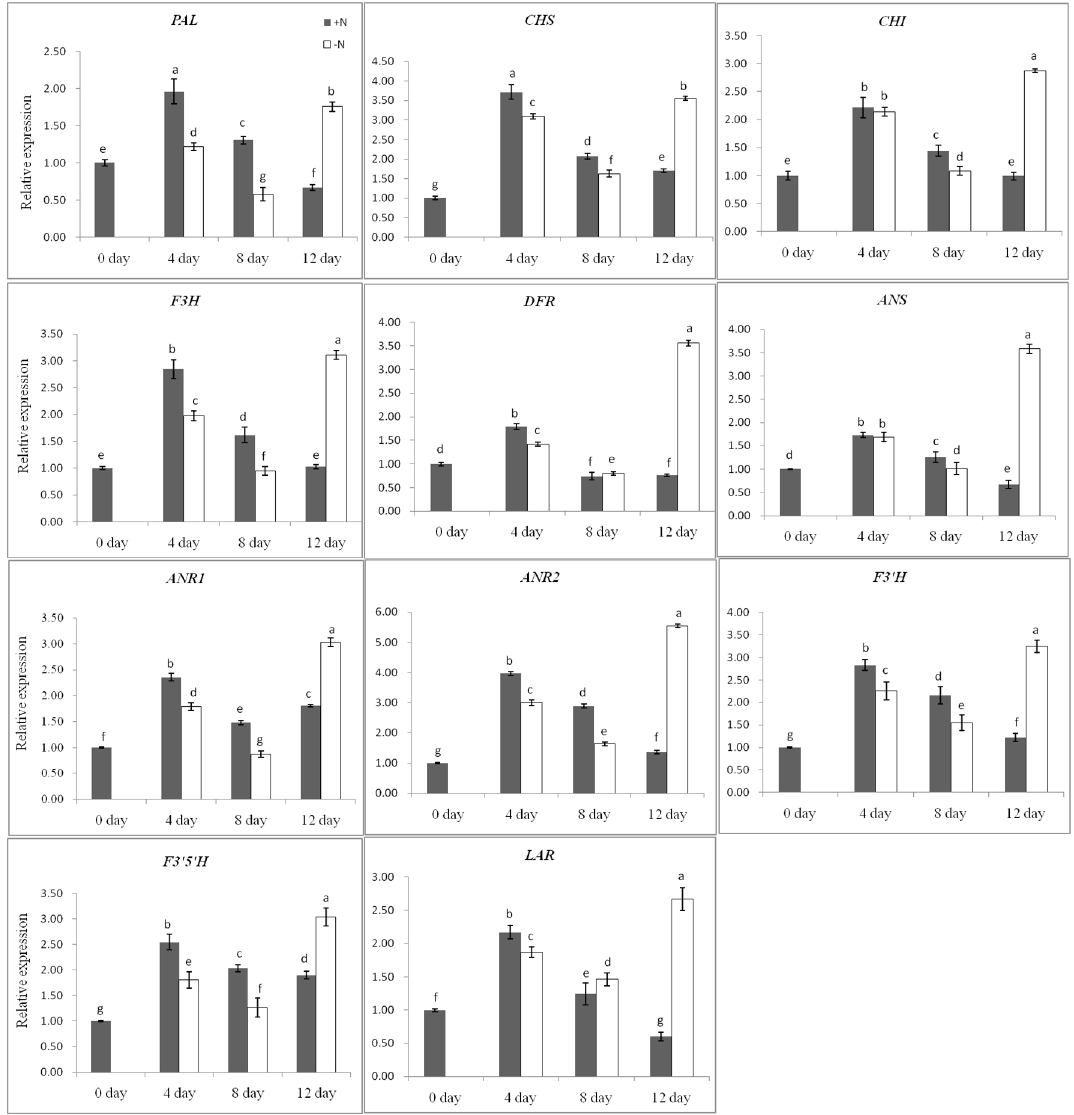
Figure 9. Expression levels of CsF3’H and other flavan 3-ol biosynthesis related genes in nitrogen deprived tea plants. The data represents the mean ± SD from three independent measurements. Means in each column for each genes labeled with the same letter are not significantly different ( p > 0.05) based on one-way ANOVA with Duncan’s multiple range test.